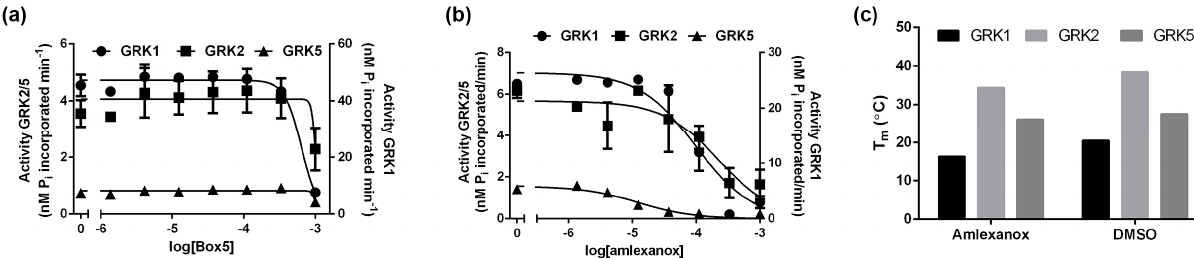
Figure 2. Amlexanox inhibits GRK activity. ( a ) Box5 only inhibits at high concentrations in a manner consistent with nonspecific inhibition. Shown are representative dose response curves performed in duplicate representing inhibition of rhodopsin phosphorylation by GRK1 (circles), GRK2 (squares), and GRK5 (triangles). ( b ) Amlexanox inhibits rhodopsin phosphorylation by GRK5 with higher potency than GRK1 and GRK2. In panels a and b, error bars represent the standard error of the mean (SEM). ( c ) Amlexanox (200 µM) reduces the melting temperature of GRK1, GRK2, and GRK5 by 4.1, 4.0, and 1.4 °C, respectively, relative to DMSO controls. Thus, amlexanox destabilizes GRKs at this concentration. Data shown is representative of 3 experiments performed in triplicate, error bars represent the SEM.